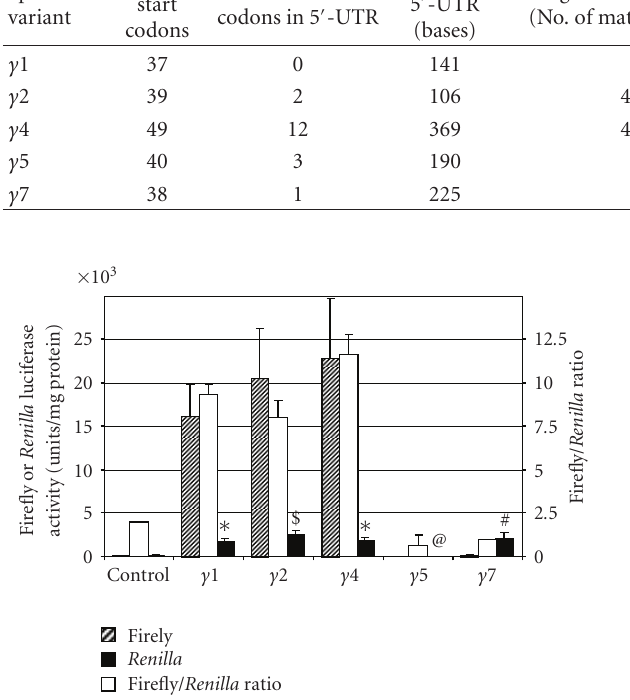
Figure 3: In vivo reporter gene assays. Firefly luciferase reporter gene constructs were designed to contain individual 5 (cid:2) -UTRs upstream of the luciferase reporter gene in the pGL3 vector